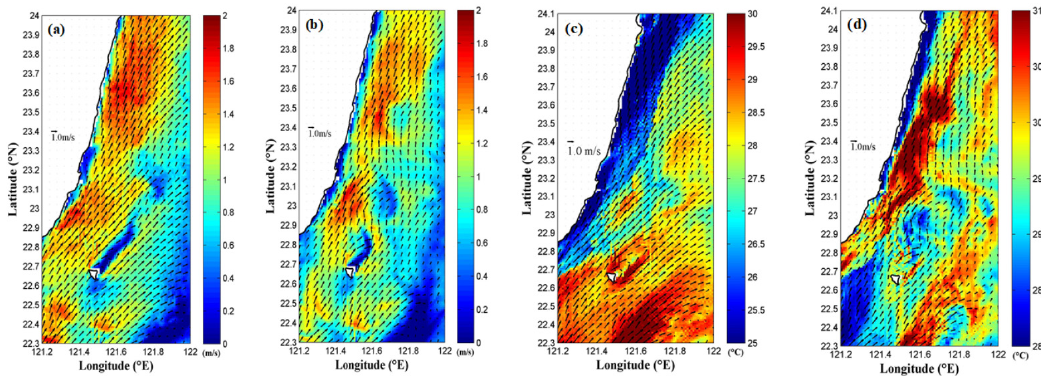
Figure 12. Velocity fields of ( a ) the SW wind condition and ( b ) the NE wind condition.